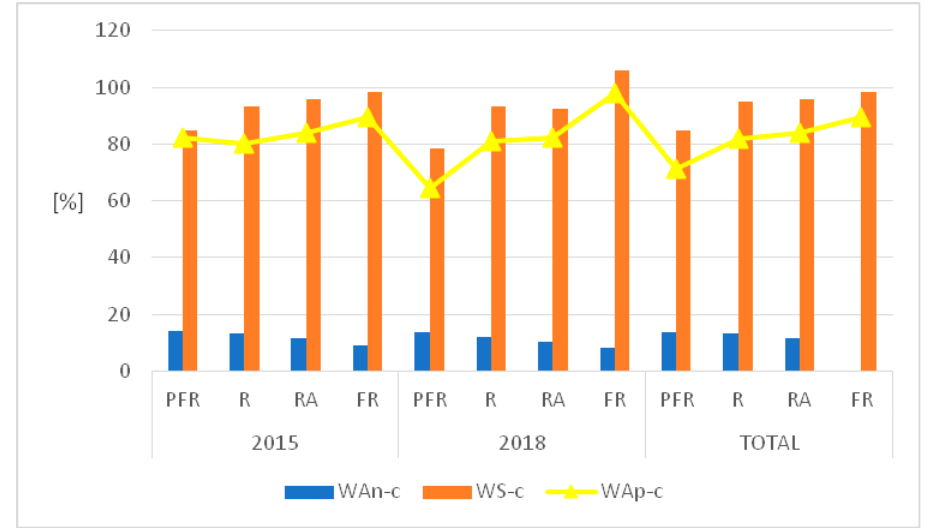
Figure 5. The values of indicators of antropogenic transformations in the flora of shore sectors of Lake Piaseczno in 2015 and 2018. WAn-c, total anthropophytisation; WS-c, total synanthropisation; WAp-c, total apophytisation.